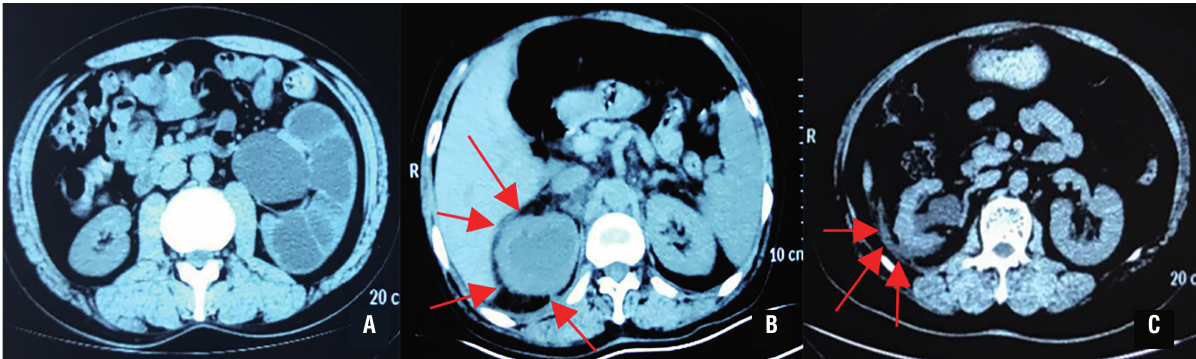
Figure 3 - MAP score. A) type 1: no stranding; B) type 2: thin and mild stranding; C) type 3: diffuse, thick-banded